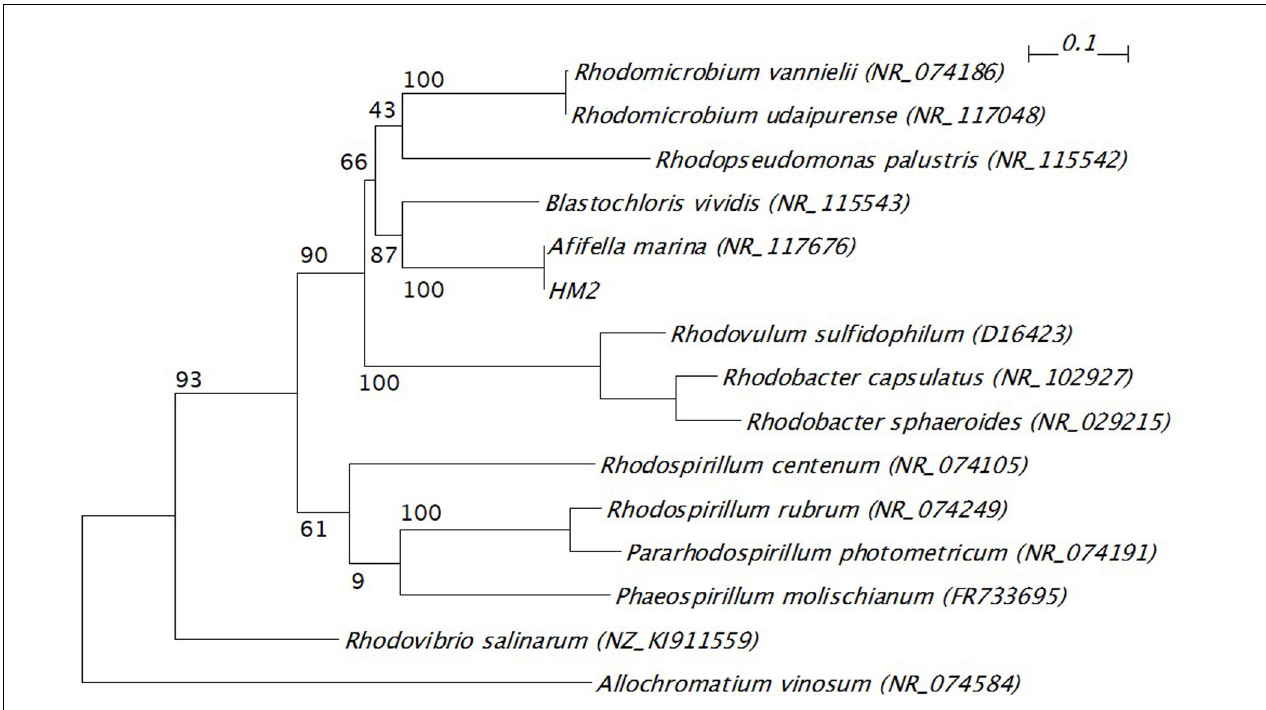
FIGURE 3 | Phylogenetic tree of 16S ribosomal RNA gene from HM2 and purple non-sulfur photosynthetic bacteria. The scale bar shows the number of nucleotide substitutions per site. GenBank accession numbers are given in parentheses. The bootstrap values are shown at branch nodes. Allochromatium vinosum was used as an